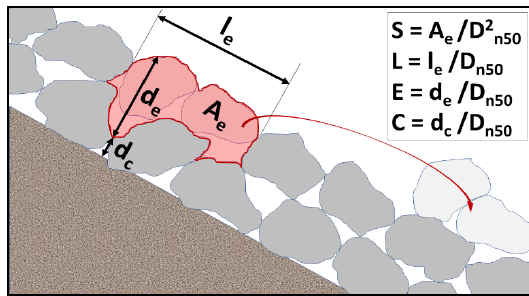
Figure 2. Sketch of a breakwater section with the definition of some damage parameters. Adapted from Melby [26].